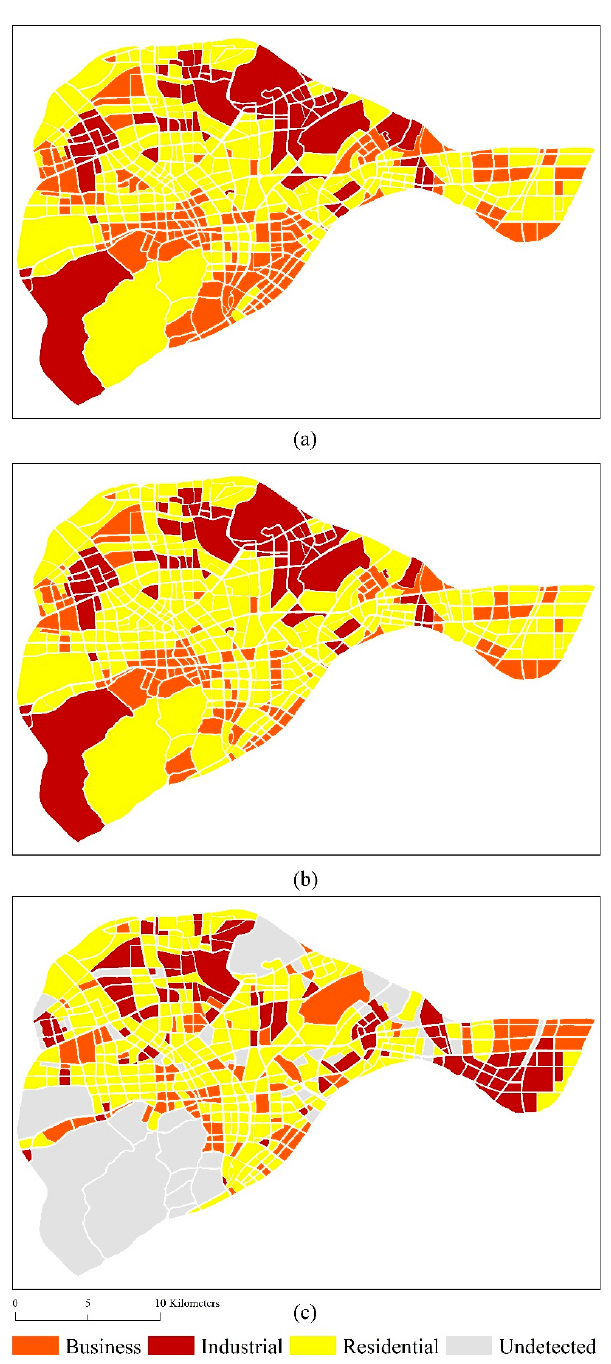
Figure 11. Comparison between the clustering results of ( a ) k = 5, ( b ) k = 8 and ( c ) 2016 Urban Master Plan.